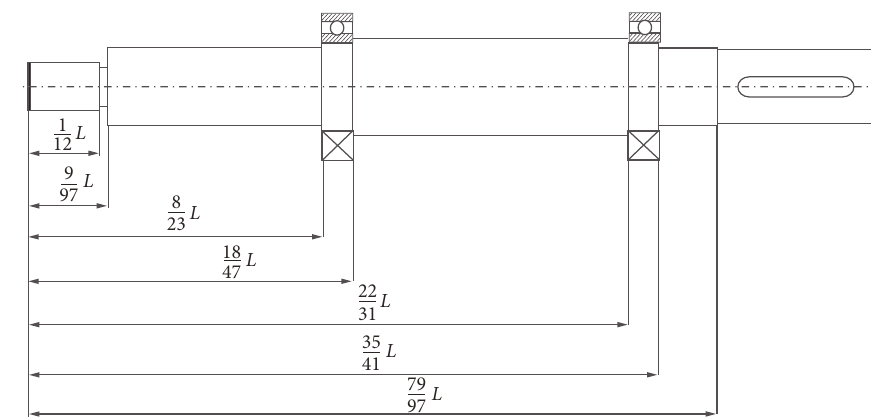
Figure 23: Ratio of each section to total length of the pump shaft. Table 10: Moment of inertia and β of each section of the pump shaft.